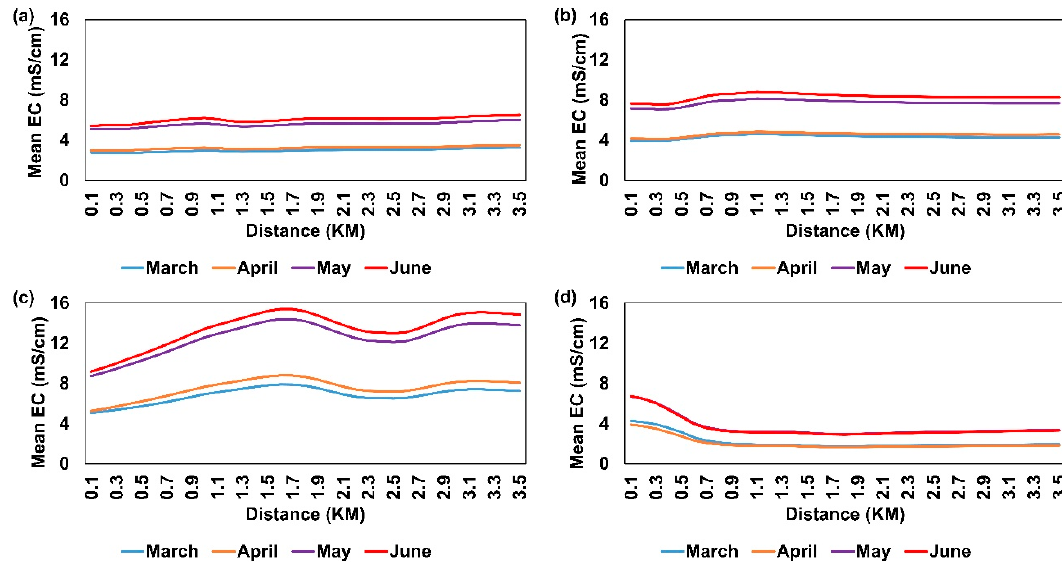
ISPRS Int. J. Geo-Inf. 2018 , 7 , 20